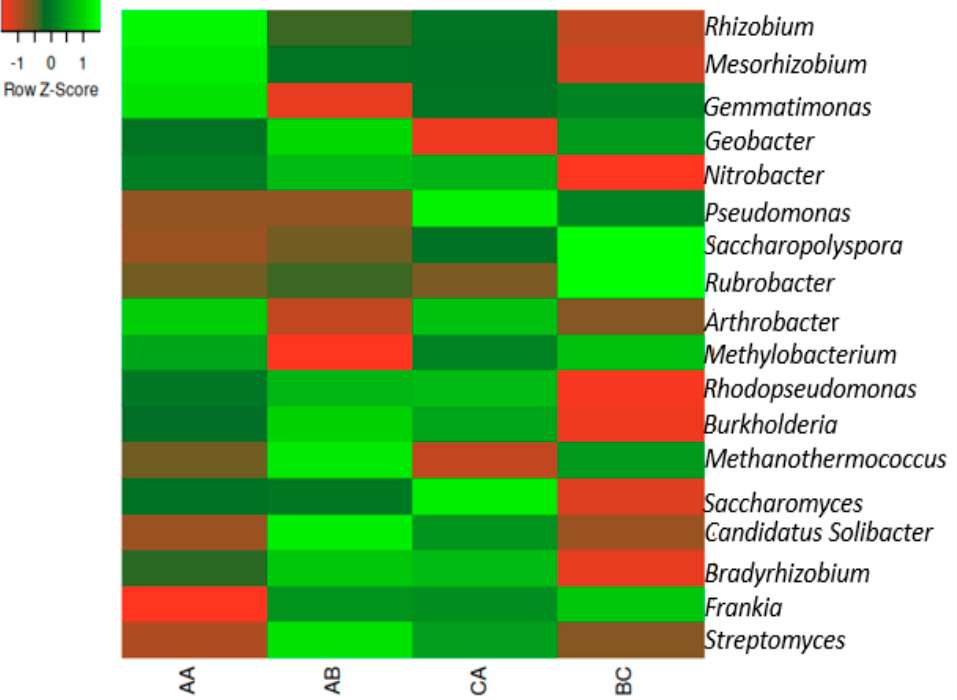
Figure 1. The heatmap representation of the relative abundances of the Phyla in the samples. The scale bar depicts a color saturation gradient based on relative abundances of the Phyla that have been z-score converted. AA, AB, and CA are rhizosphere soil samples while BC is a bulk soil sample.